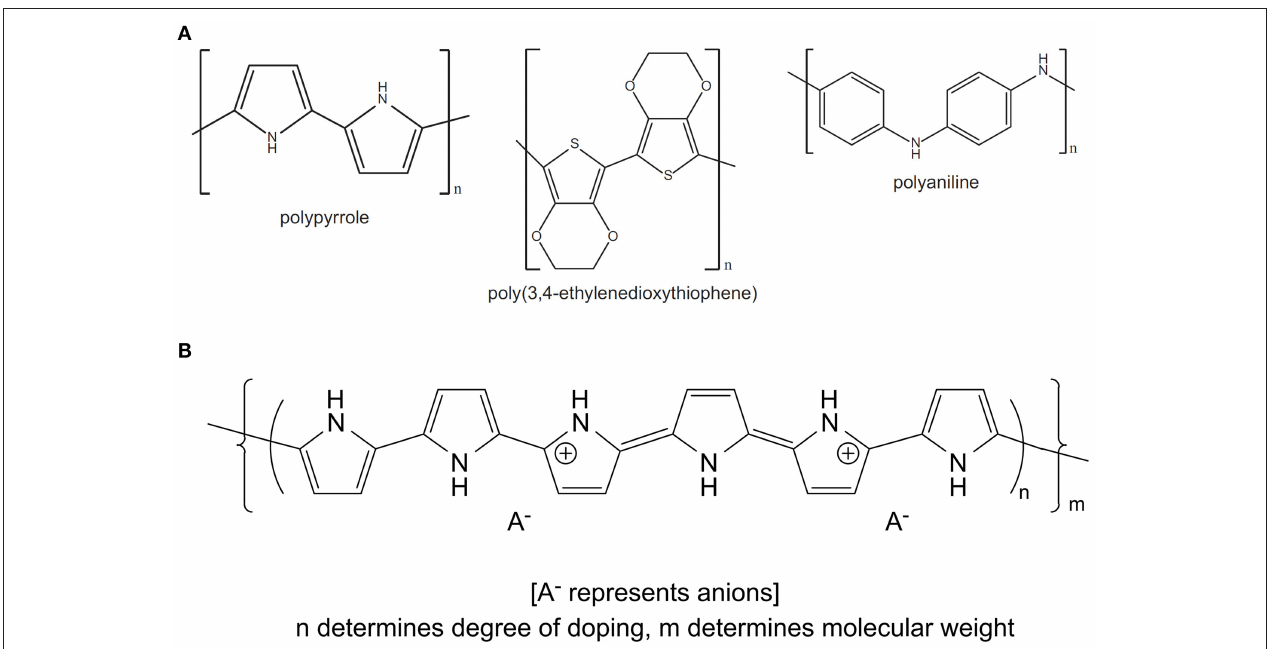
FIGURE 1 | (A) Chemical structures of the common OCPs polypyrrole, poly(3,4-ethylenedioxythiophene) and polyaniline. (B) Schematic illustrating the incorporation of a dopant anion during oxidation of monomeric species to form the OCP conjugated backbone (PPy). (B) Reproduced with permission from Gilmore et al. ( 27).